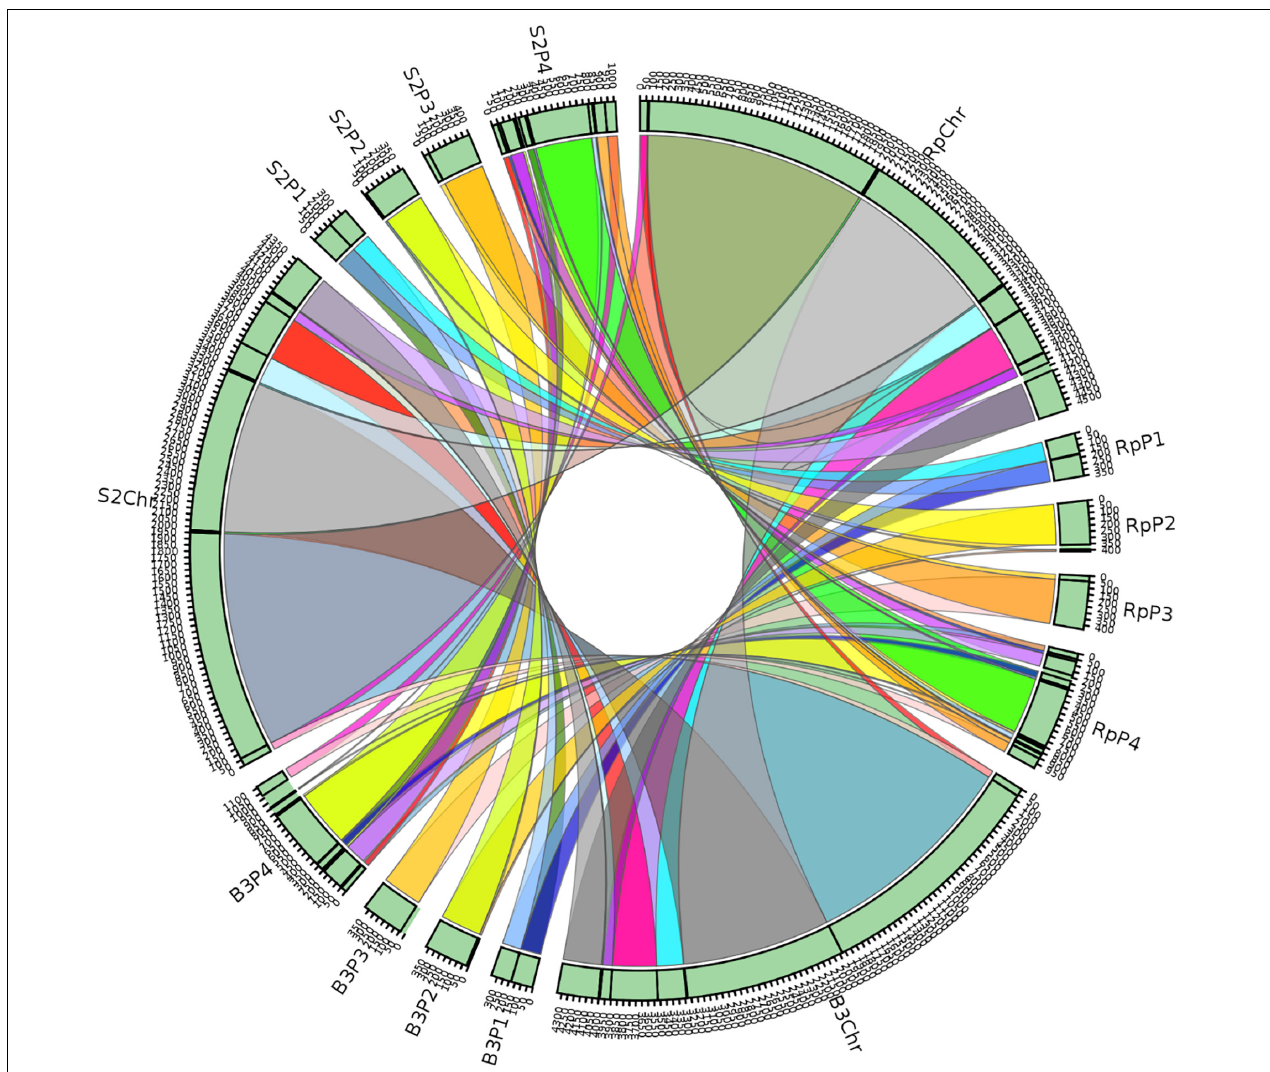
FIGURE 7 | Synteny blocks between the isolates B3, S2, and R. phaseoli . Rp, R. phaseoli ; Chr, chromosome; P1–P4, plasmids